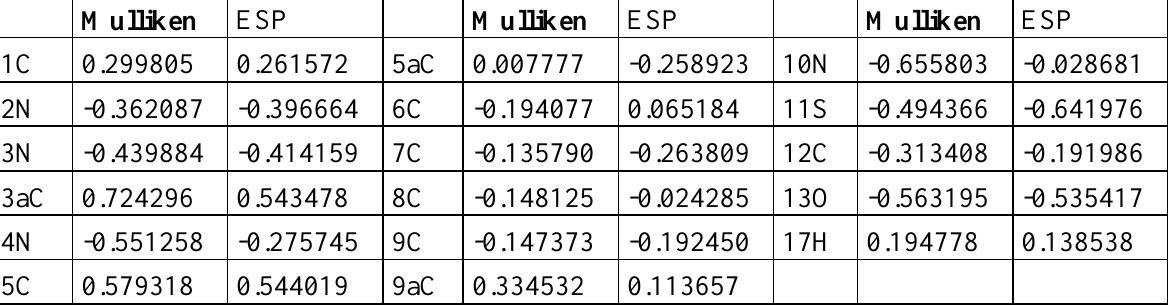
Table 2. The Partial charges of the anion form of 1 .